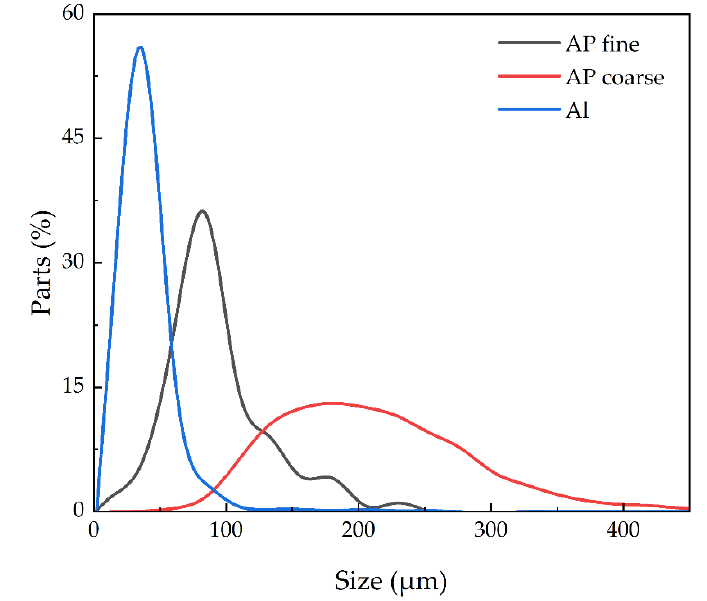
Figure 1. The size distribution of AP fine, AP coarse and